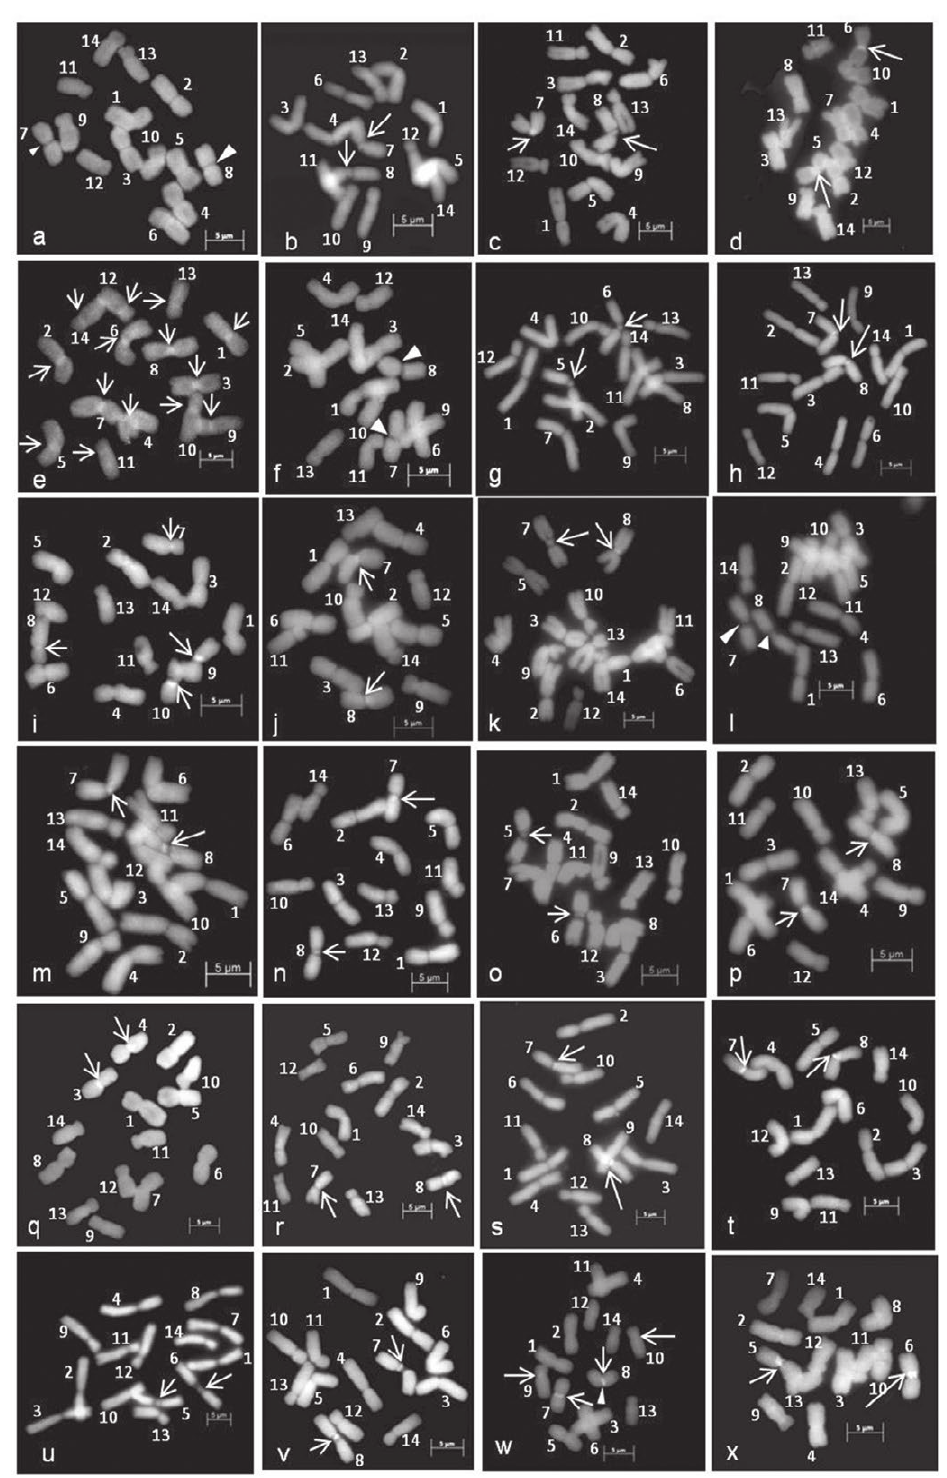
Figure 1. Somatic metaphase chromosomes of Lens culinaris cultivars stained with CMA: (a) DPL-15, (b) DPL-62, (c) IPL-81, (d) IPL-406, (e) IPL-316, (f) JL-1, (g) HUL-57, (h) KLS-210, (i) EC-70394, (j) EC-70403, (k) EC-70404, (l) EC-78452, (m) EC-78455, (n) EC-78461, (o) EC-78475, (p) EC-78498, (q) EC-78542-A, (r) EC–223188, (s) EC – 255491, (t) EC–267526, (u) EC-267569-A, (v) EC–267590, (w) EC–267877, (x) Barasat Micro type. White arrows indicate CMA + bands and arrowheads indicate CMA 0 bands. Bars